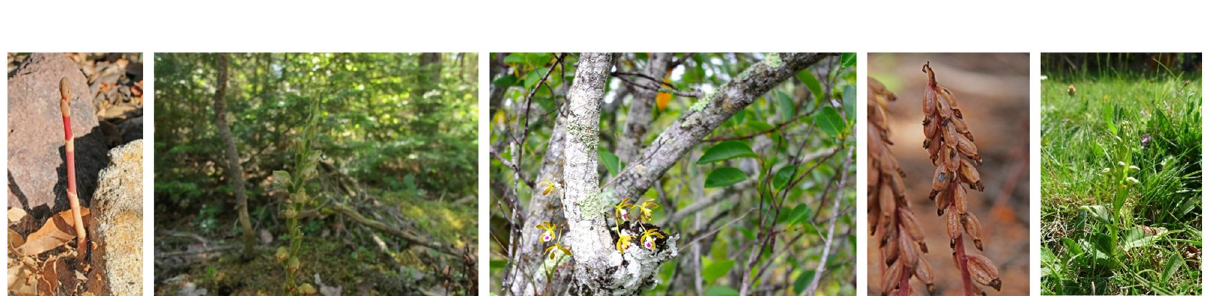
PLOS ONE | https://doi.org/10.1371/journal.pone.0259036 October 27, 2021 23 /